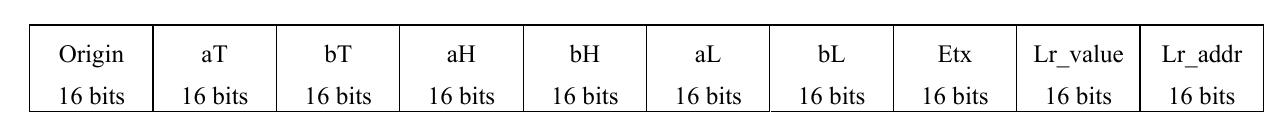
Figure 6. Coefficients packet length (version